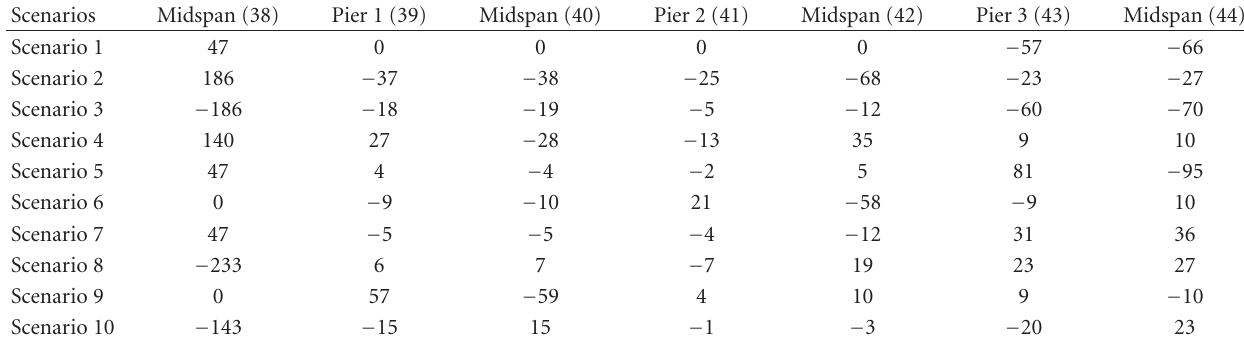
Table 5: Live load stresses from deflections (analytical)—north side panels (psi ∗